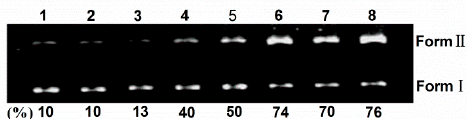
Figure 5. Photocleavage of pBR322 DNA (0.1 μ g) by various concentrations of TCPC in Buffer II (pH = 7.2). lane 1, DNA alone (light); lane 2, DNA alone (dark); lane 3, DNA + 80 μ M TCPC (dark); lane 4, DNA + 20 μ M TCPC; lane 5, DNA + 40 μ M TCPC; lane 6, DNA + 80 μ M TCPC; lane 7, DNA + 120 μ M TCPC; lane 8, DNA + 160 μ M TCPC.